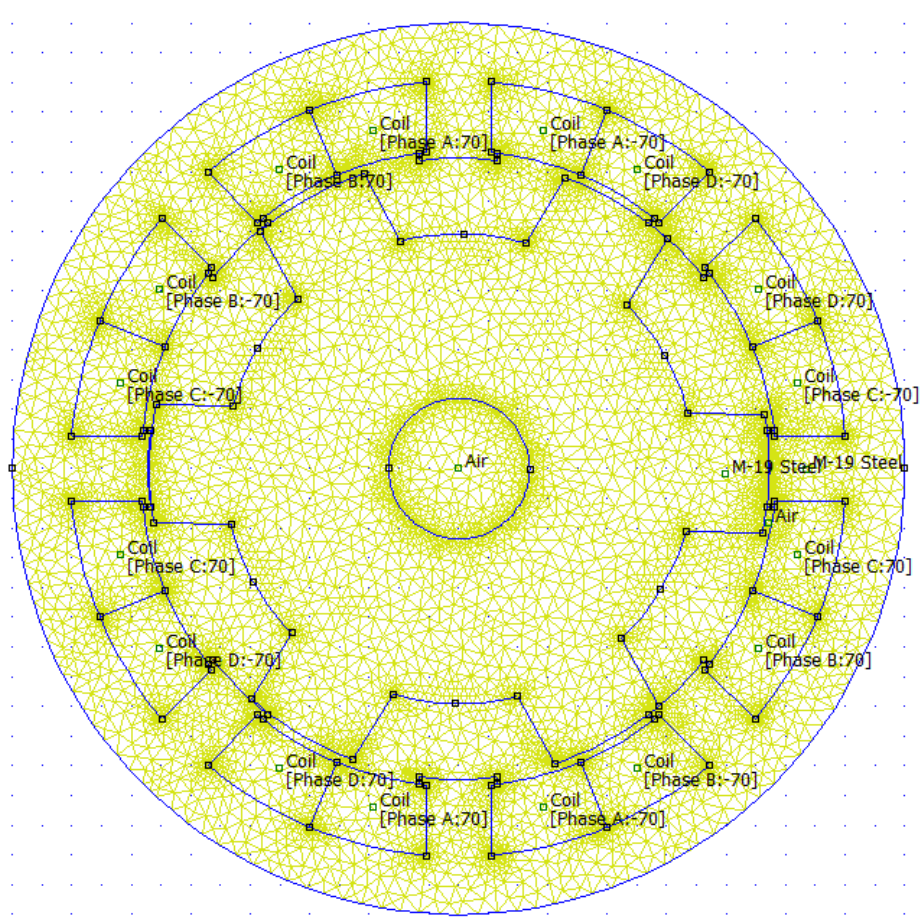
Figure 8. Mesh and material boundaries created in FEMM package for SRM.